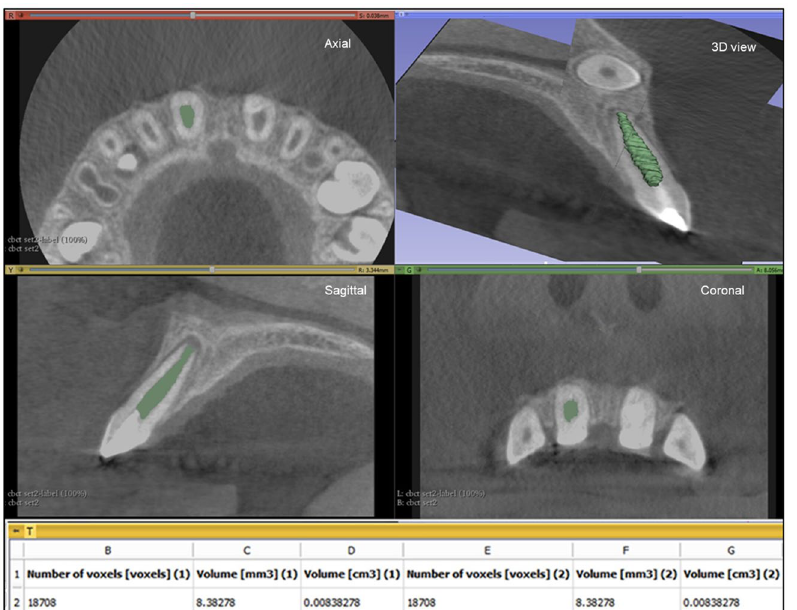
Figure 4. Pulp space volume assessment using 3D Slicer: illustrates the ROI in the axial, saggital and coronal slicing as well as the reconstructed 3D model with the calculated volume.